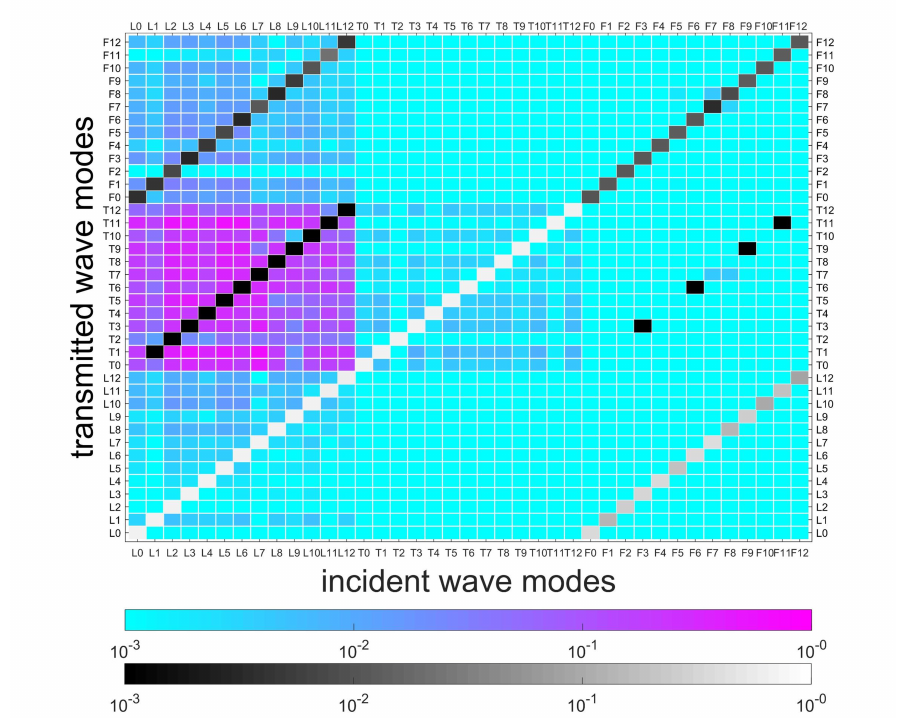
Figure 14. Transmitted waves of coupling element with damage (50% Young’s modulus loss in 15 ◦ ). The marked conversions in Figure 12 are caused by both the flange and damage in this case. Hence, they are painted by a gray color-bar to distinguish them from wave-mode conversion induced by